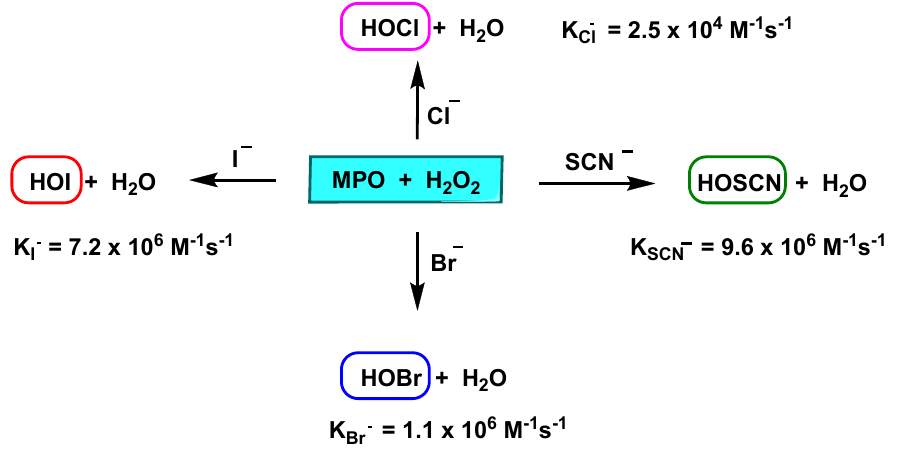
Figure 4. Catalysed conversion of Cl − , Br − , I − , and SCN − by MPO, with second-order constants K. MPO oxidises chloride, bromide, iodide, and thiocyanate ions (H=Cl − , Br − , I − , and SCN − ), to the respective HOX acids. With a 100 mM concentration of Cl − , MPO catalyses OSCN − production at SCN − concentrations of 25 μ M, and at 100 μ M of SCN − , approxi- mately 50% of H 2 O 2 is converted to OSCN − [19]. The loss of H 2 O 2 induced by MPO in the presence of 100 mM Cl − doubled when 100 μ M of SCN − was added and was maximal at 1 mM of SCN − . It is concluded that SCN − is an important physiological substrate of MPO [19]. The transition from SCN − to HOSCN by MPO is an important detoxification mechanism by removing the oxidant H 2 O 2 and subsequently HOCl [21].